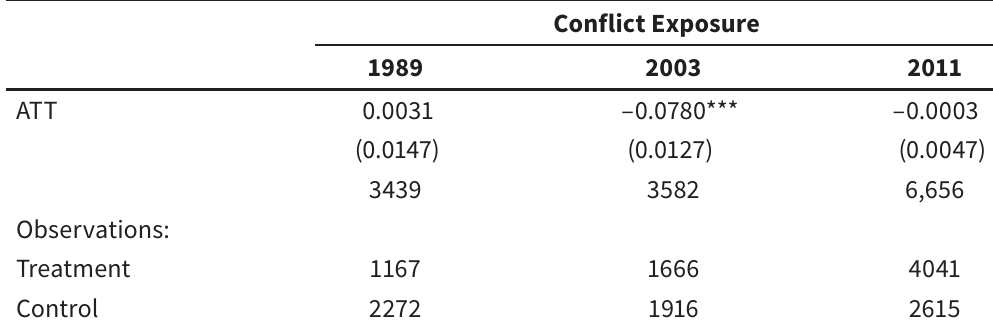
Table A2.10 The Impact of Conflict on the Gini Coefficient using the Inverse Probability Weighting Procedure (without